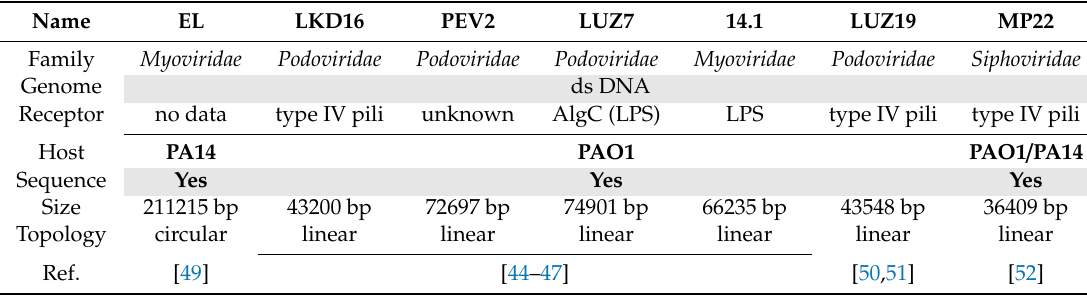
Table 2. Phylogeny and molecular characteristics of the phages